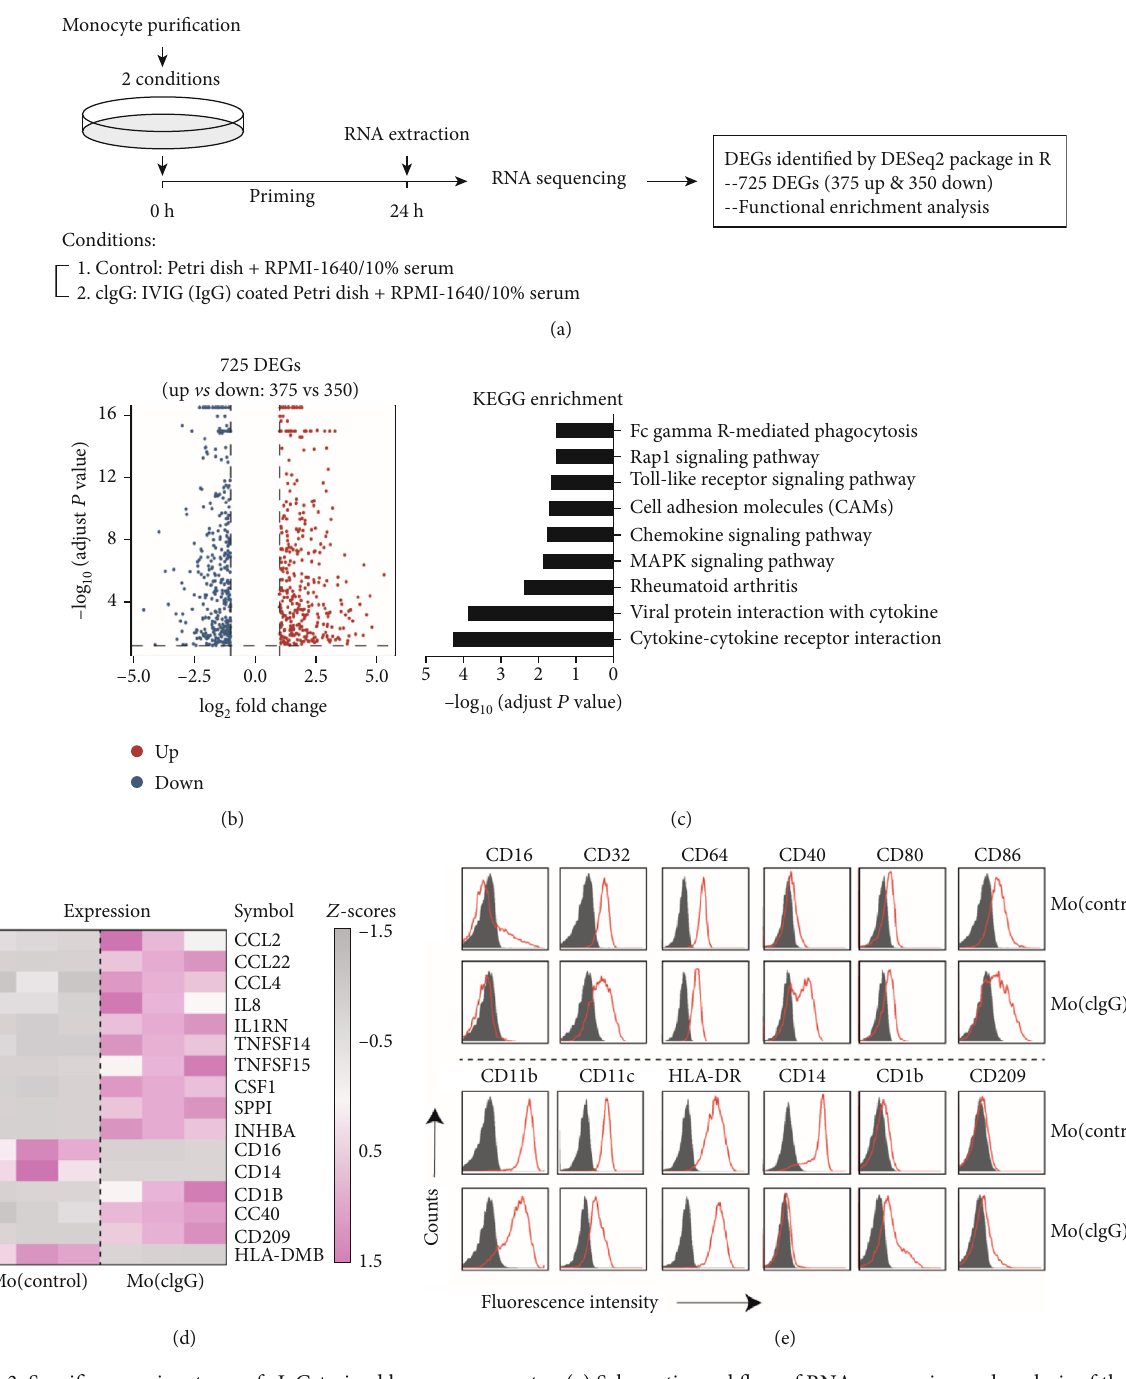
Figure 3: Speci fi c gene signatures of cIgG-trained human monocytes. (a) Schematic work fl ow of RNA sequencing and analysis of the cIgG- trained monocytes. (b) Volcano plot of 725 DEGs from Mo(cIgG) as compared with Mo(control). (c) Bar plot of KEGG enrichment analysis of DEGs in Mo(cIgG). (d) Heatmap showing the signature cytokine, chemokine, and cellular marker genes expressed in Mo(cIgG) and Mo(control). (e) Flow cytometric analysis of Mo(cIgG) stained with isotype control Abs ( fi lled histogram) and speci fi c markers as indicated